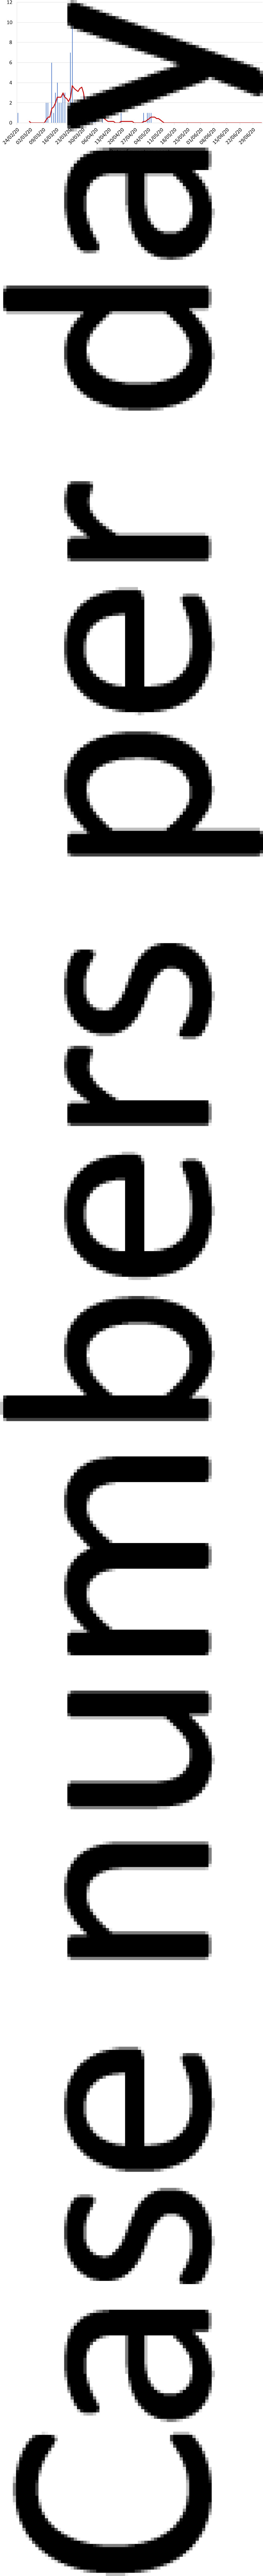
Dates of coronavirus disease 2019 symptom onset. Red line represents 7-day rolling average.